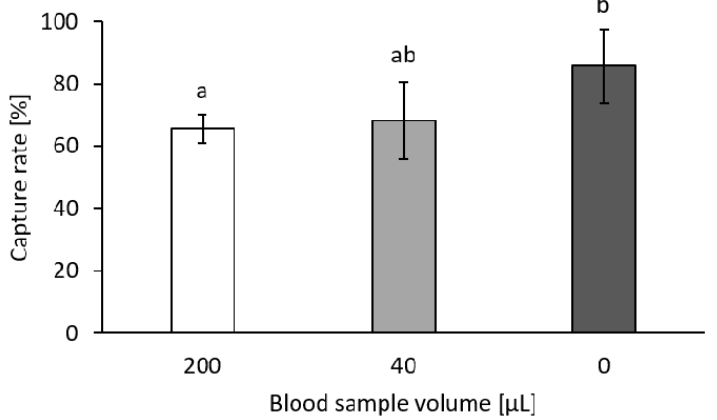
Figure 9. HCT116 cell capture rate dependent on the whole blood sample volume. Stained cells were spiked into 200 µ L and 40 µ L whole blood or 1 × PBS/1% BSA/1 mM EDTA as control. Results are given as means ± SD. Different letters (a and b) above the bars indicate statistical difference ( n = 5; p < 0.05).